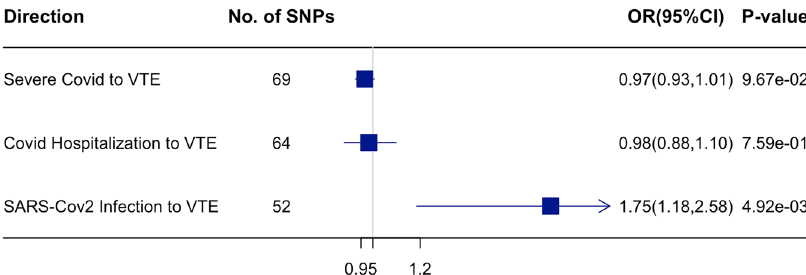
Fig. 6 Mendelian randomization analysis on the association of genetically predicted COVID-19-related traits with the risk of VTE using IVW. The estimates are presented as odds ratios (OR) with 95% con fi dence intervals (CI). An arrow represents the estimate that is out of the boundary in this direction. The presented data are available in Supplementary